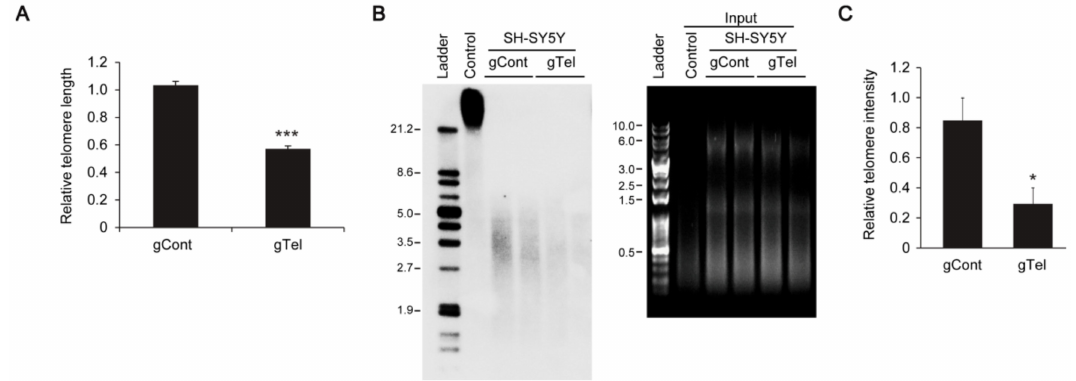
Figure 1. Reduction of telomere repeats by telomere targeting CRISPR-Cas9 in SH-SY5Y cells. ( A ) Quantification of telomere repeats in SH-SY5Y cells transiently transfected (48 h) with lentiCRISPR-gRNA-telomere (gTel) or mock plasmid (gCont) determined by real-time quantitative PCR using telomere specific primer sets. Relative telomere average length was normalized to the amounts of genomic locus 36B4u ( n = 3 per group); ( B ) Representative Southern blot images showing telomere restriction fragments obtained from the same amounts of genomic DNA extracted from SH-SY5Y cells transfected with gTel or gCont (48 h). Telomere fragments were detected by telomere sequence specific probe (left panel). Hinf I/Rsa I digested genomic DNA separated on agarose gel and visualized by RedSafe nucleic acid staining as loading control for Southern blot (right panel); ( C ) Quantification of telomere intensities determined by Southern blot experiments normalized by digested genomic DNA loading amounts ( n = 3 per group). Quantified data are expressed as mean ± SEM. Statistical significance was determined by unpaired two-tailed Student’s t test, * p < 0.05, and *** p <